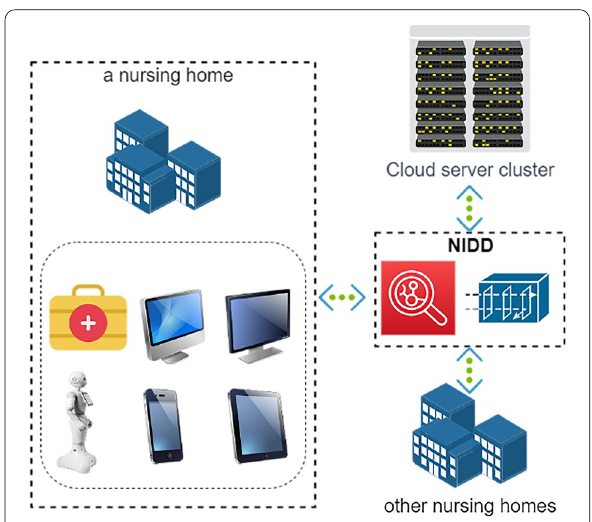
Fig. 1 Application scenario of intelligent intrusion